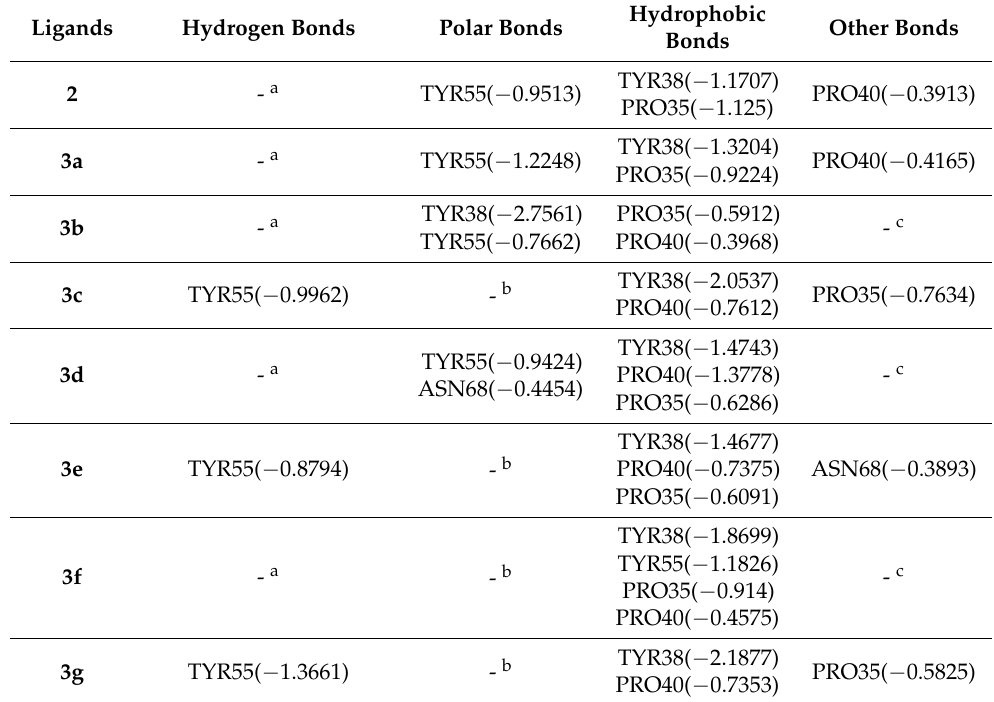
Table 6. Decomposed interaction energies in Kcal/mol of compounds 2 , and 3a – g into